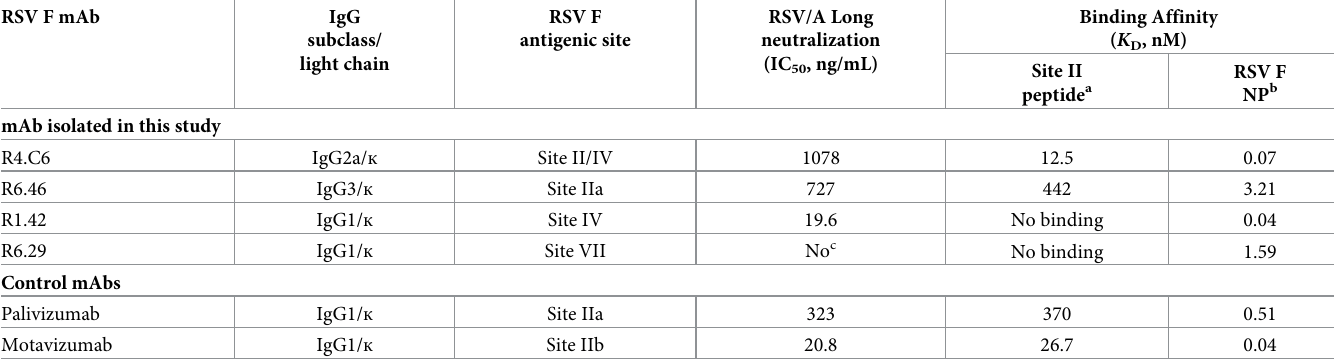
Table 1. Characterization of RSV F-specific